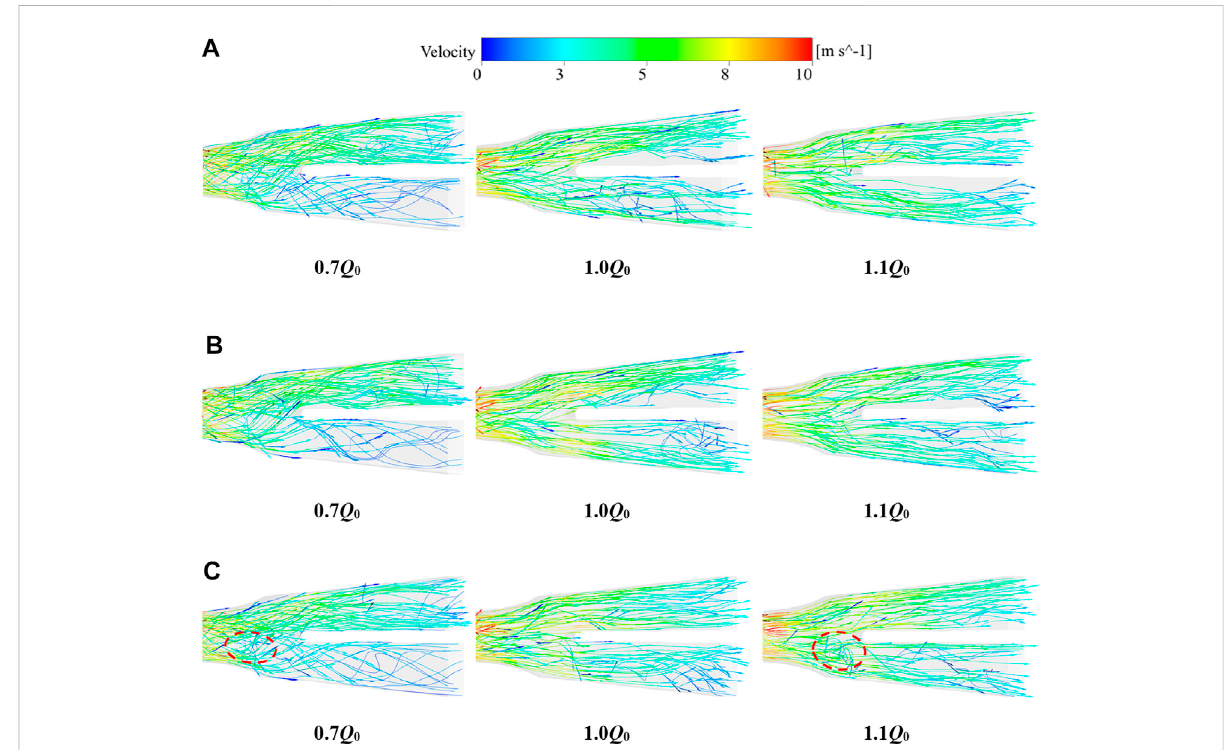
FIGURE 7 Three-dimensional Streamlines in the outlet channel: (A) IR pump, (B) GVR pump, and (C) CR pump.